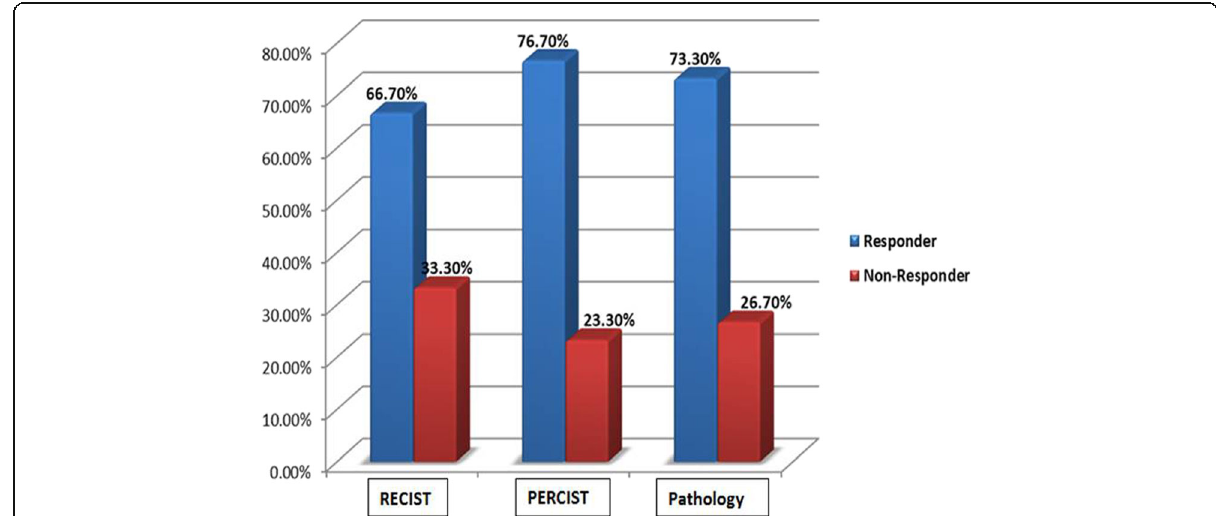
Fig. 7 Distribution of the studied patients according to response to NAC determined by RECIST 1.1, PERCIST 1.0, and histopathology